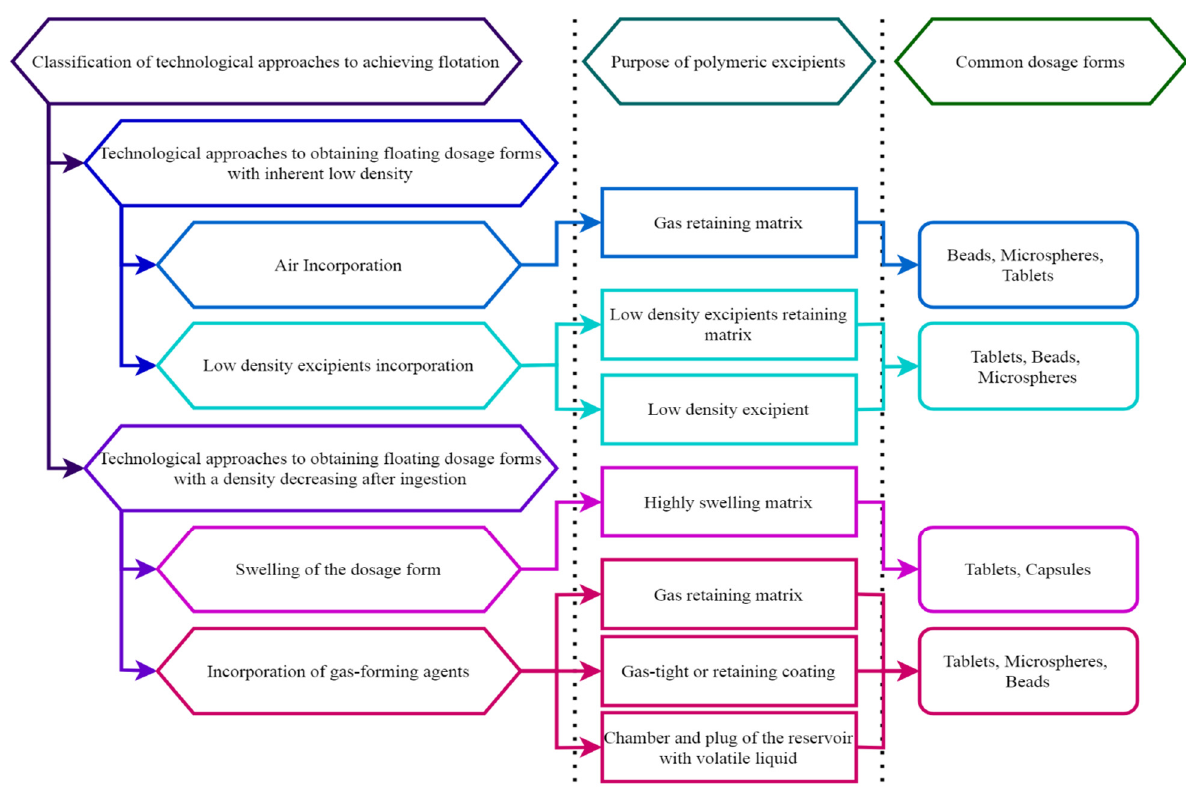
Figure 2. Classification of technological approaches to achieve flotation, the purpose of polymers in these approaches, and the most common dosage forms.